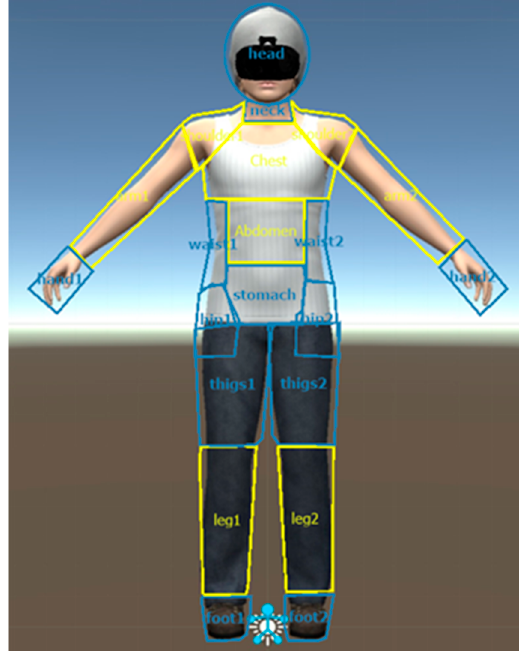
Figure 1. Weight-related and non-weight-related areas of interest on the female virtual avatar.